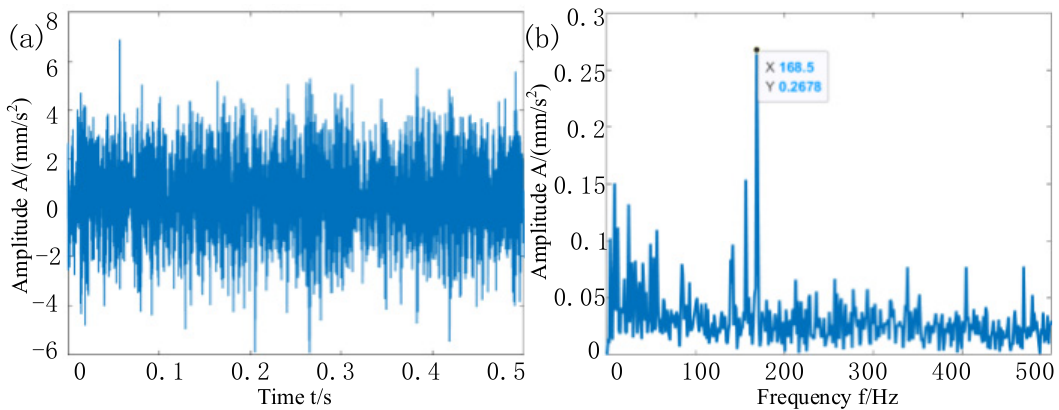
Figure 24. Result of the test bearing.( a ) Time-domain waveform of the vibration signal; ( b ) enve- lope spectrum of the vibration signal. spectrum of the vibration